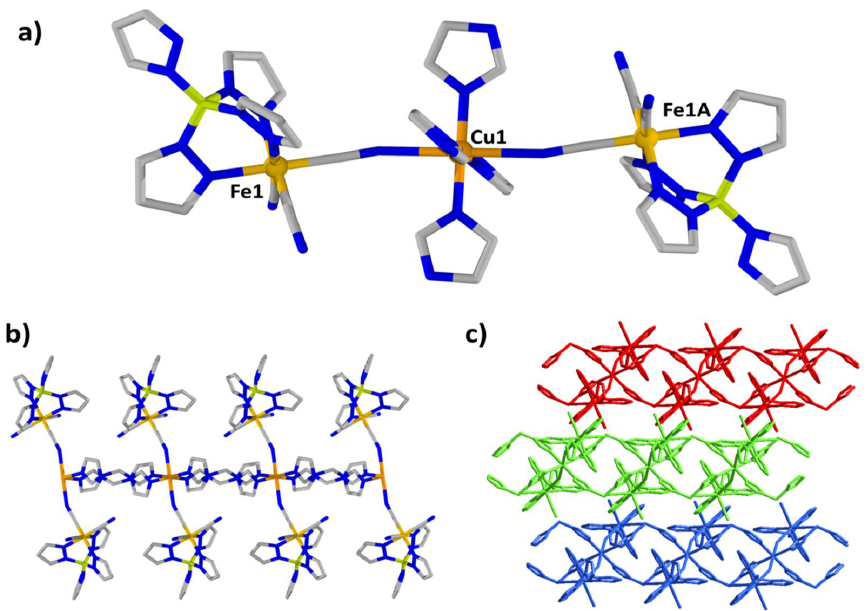
Figure 3. ( a ) The coordination surrounding of Fe 3+ atom and Cu 2+ atom in 2 ; ( b ) the one-dimensional chain-like framework of 2 ; and ( c ) the ABAB stacking mode of 2 .